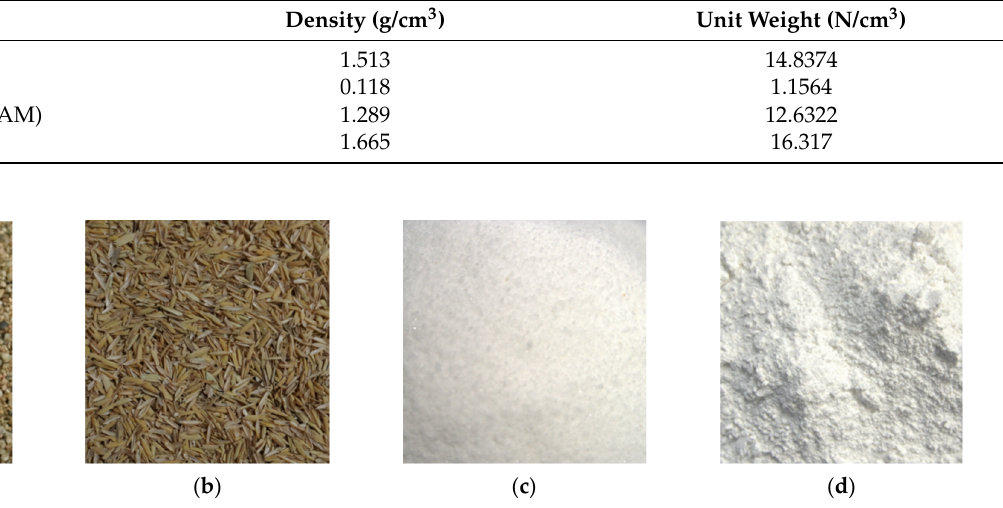
Figure 1. Macroscopic images of modified materials; ( a ) Sand; ( b ) Grain shells; ( c ) PAM; ( d ) FGD gypsum.